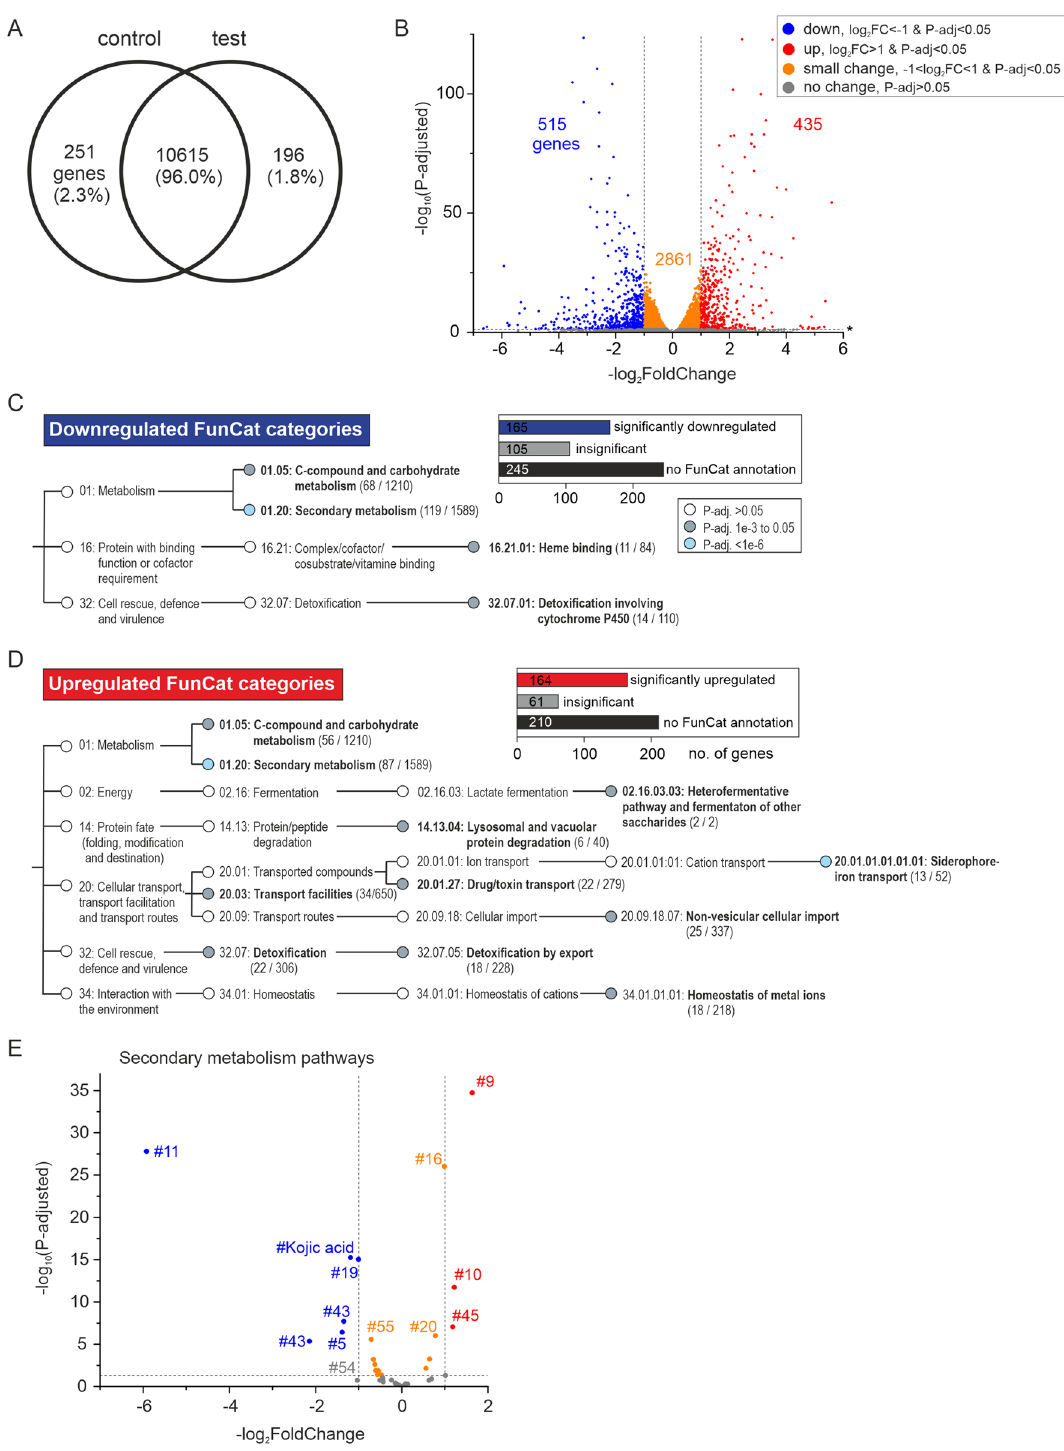
Figure 4. Effect of M20 plant extract on gene expression in A. flavus . ( A ) Venn diagram shows the number of genes expressed in both control and test groups (intersection) or uniquely in one of the two groups. ( B ) Volcano plot shows the classification of genes into downregulated, upregulated, small change or no change classes depending on their log 2 FoldChange and p- adj values. ( C ) FunCat categories that were significantly enriched among downregulated DEGs. Inset box shows the number of DEGs assigned as enriched (significant) or non- enriched (insignificant) in FunCat categories or lacking FunCat annotation. ( D ) FunCat categories that were significantly enriched among upregulated DEGs. Inset box is defined as in ( C ). ( E ) Effect of M20 treatment on SM pathways was evaluated by analyzing the expression of pathway “backbone enzyme” genes. Volcano plot shows SM pathways classified into downregulated (blue), upregulated (red), small change (orange) or no change (gray) classes depending on the log2FoldChange and p -adjusted values of backbone genes using limits detailed in ( B ). AF pathway is indicated by